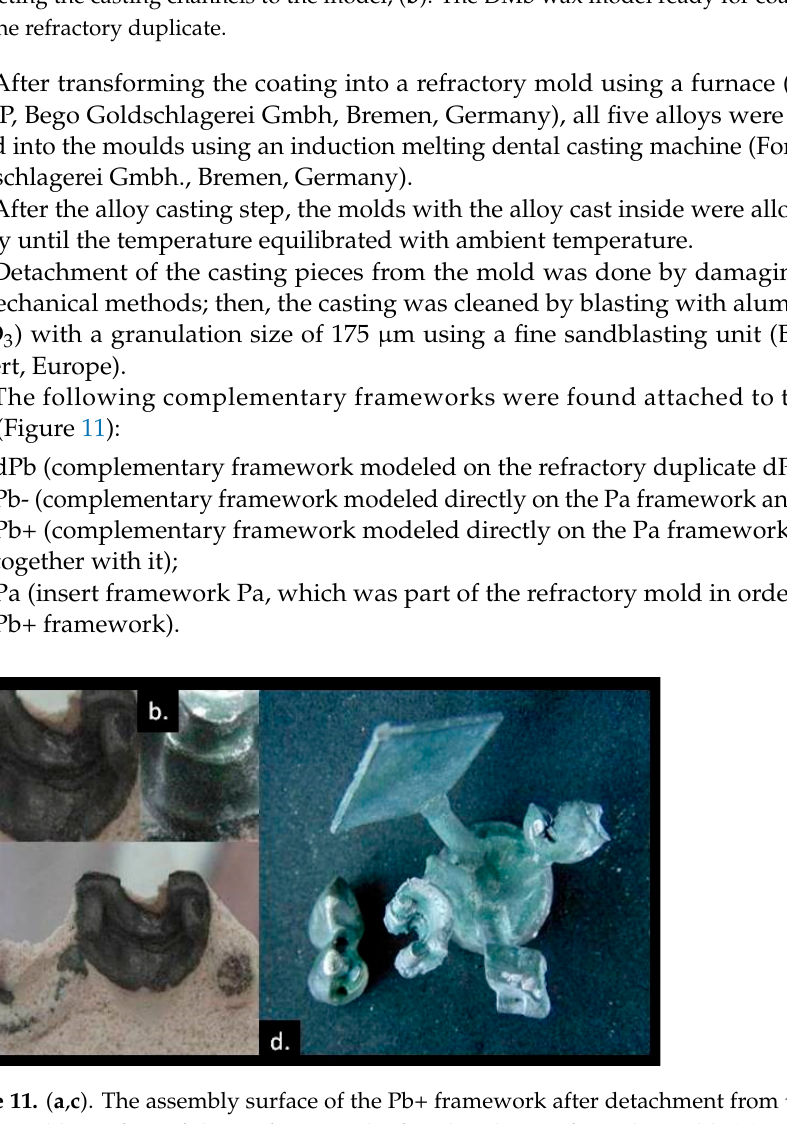
Figure 10. ( a ). The Mb + wax model and the Pa framework, Mb- resin model, prepared for coating by connecting the casting channels to the model; ( b ). The DMb wax model ready for coating together with the refractory duplicate.